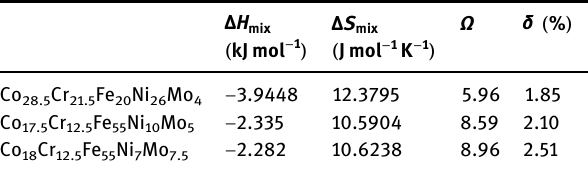
Table 5: The value of H Δ mix , S Δ mix , Ω , and δ for Co 28.5 Cr 21.5 Fe 20